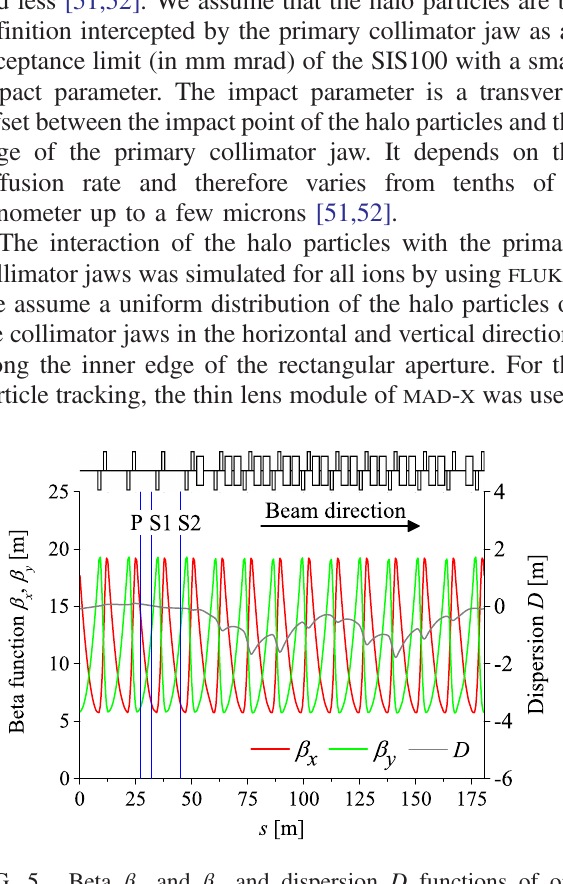
FIG. 5. Beta β x and β y and dispersion D functions of one superperiod of the SIS100 lattice for the ion operation in the fast extraction mode with the marked position of the primary and